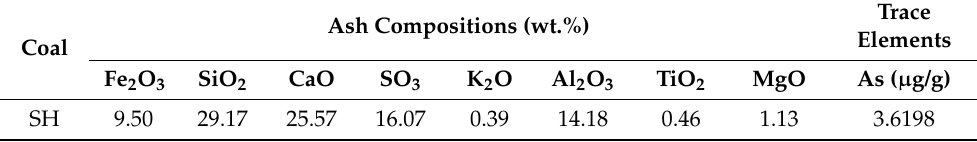
Table 2. The ash composition of